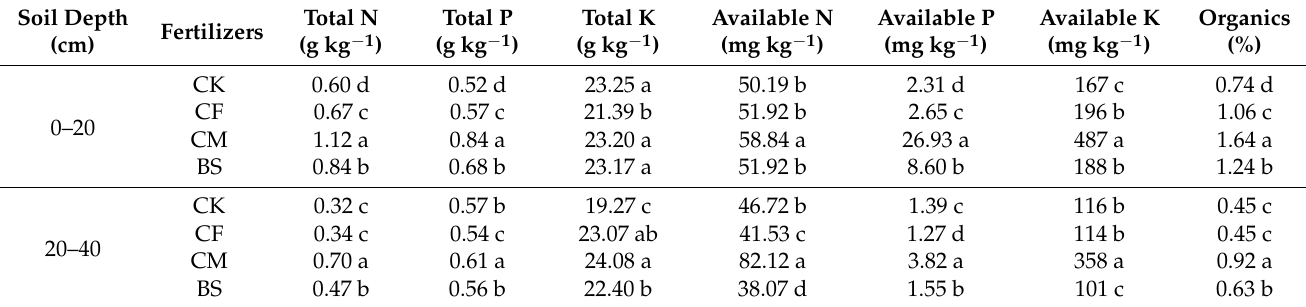
Table 5. Soil chemical properties under different fertilization treatments.